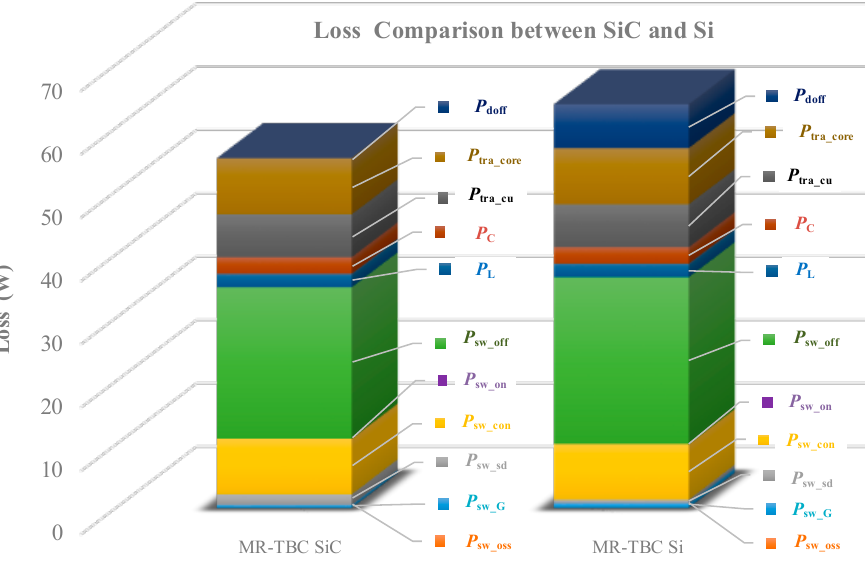
Figure 10. Loss calculation comparison between Si and SiC under 1500 W.